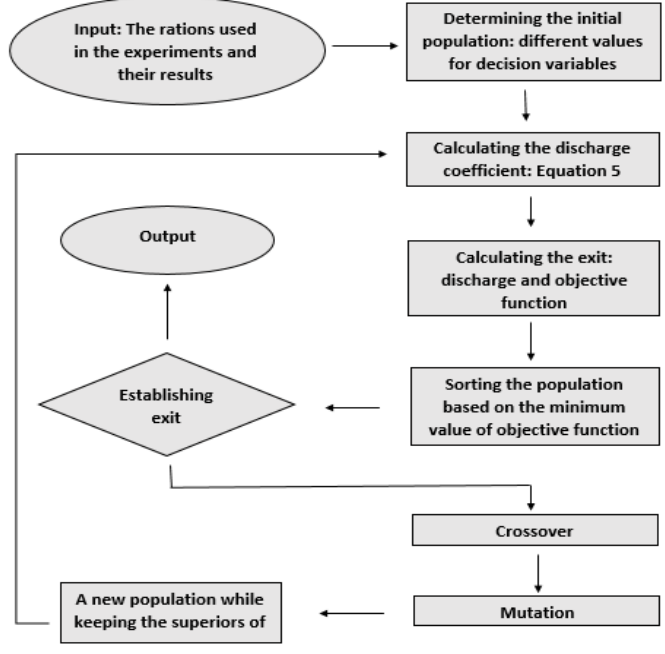
Figure 4. The schema of the suggested